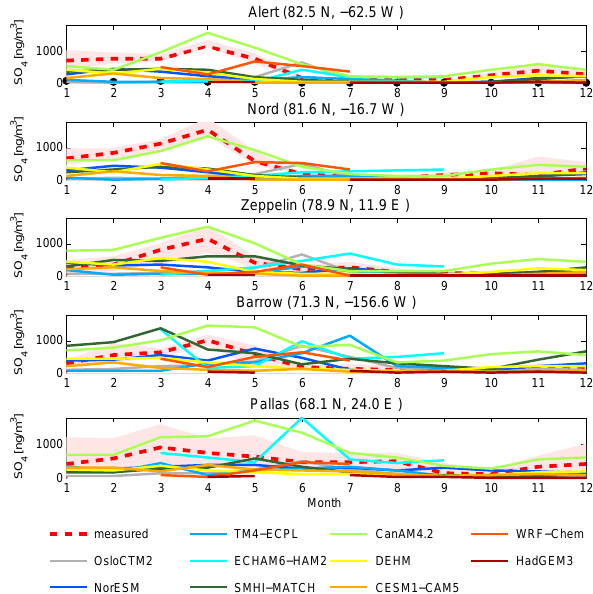
Figure 6. Monthly (month is displayed on the abscissa) median ob- served and modeled sulfate surface concentrations for the stations (from top) Alert, Nord, Zeppelin, Barrow and Pallas. The red dashed lines connect the observed median values. The light red shaded ar- eas span from the 25th to 75th percentiles of the observations. Mod- eled median values are shown with different lines according to the legend.